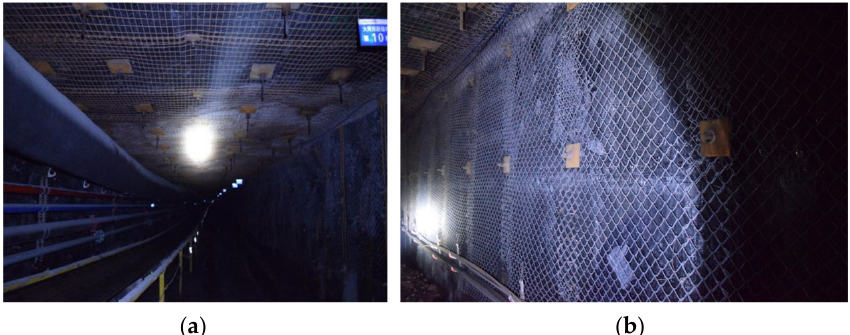
Figure 15. Picture of the roadway maintenance effect: ( a ) roadway roof; ( b ) roadway coal rib.